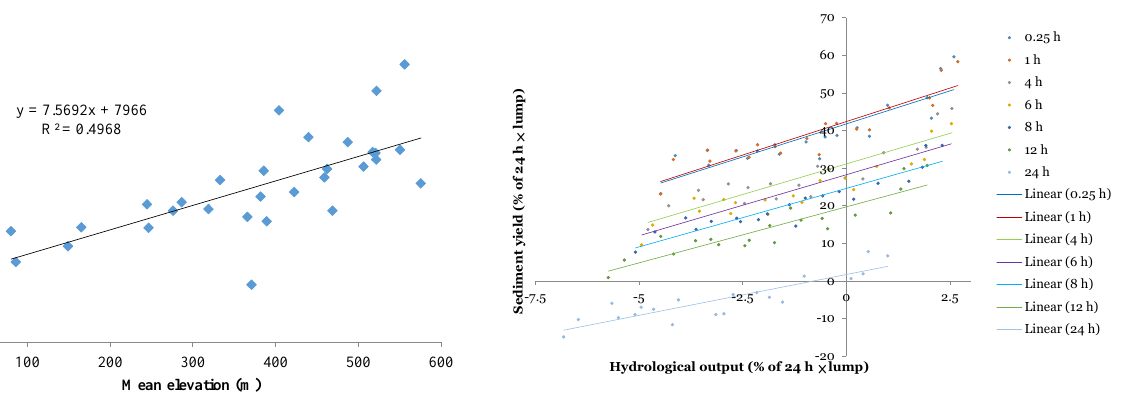
Figure 9. Relationship between the total rainfall and mean elevation for each 5 km pixel within the Complete Swale basin.